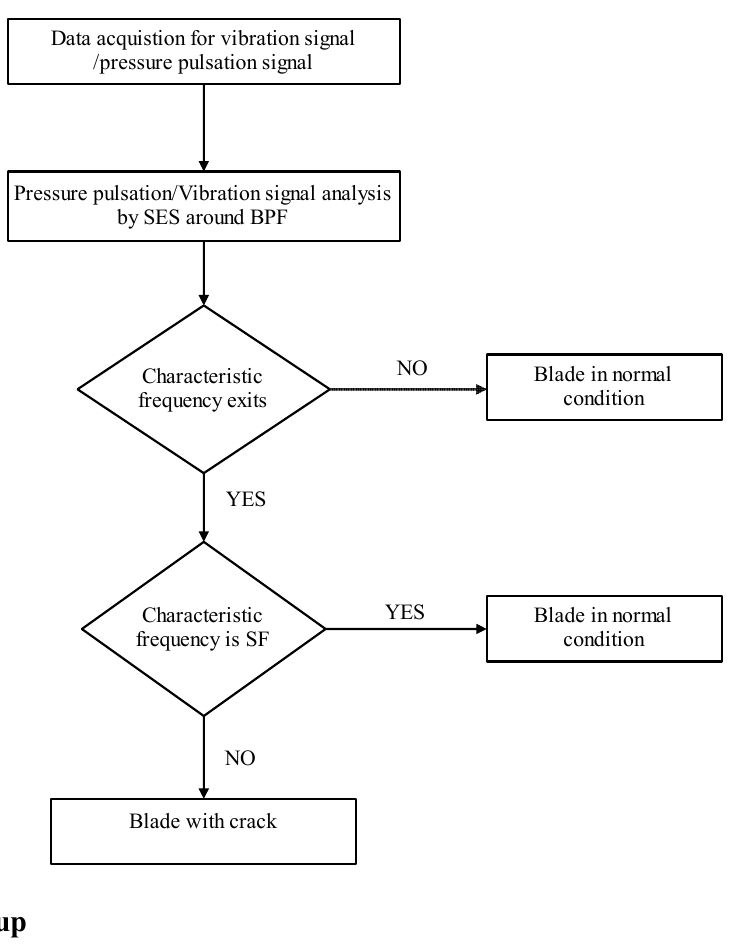
Figure 7. Flowchart for blade crack classification by using PP or vibration